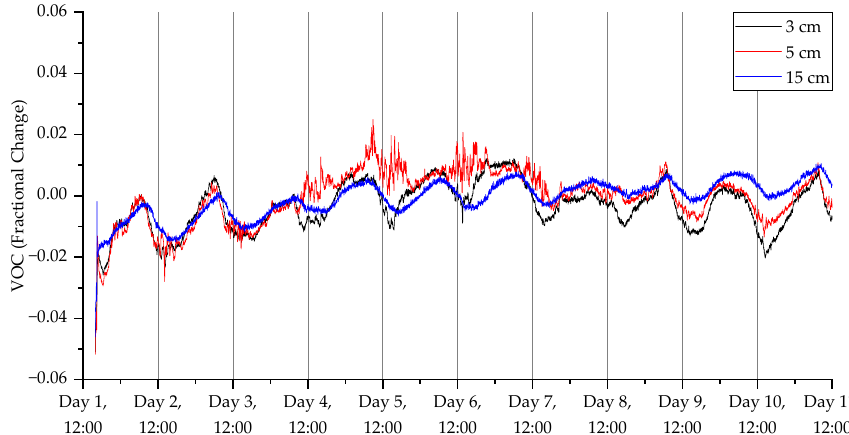
Figure 19: Temperature measurements for the third deployment in Wellesbourne cam ‐ pus woodland. Data collection commenced on 26 August 2022 at 16:00 (24 h time).